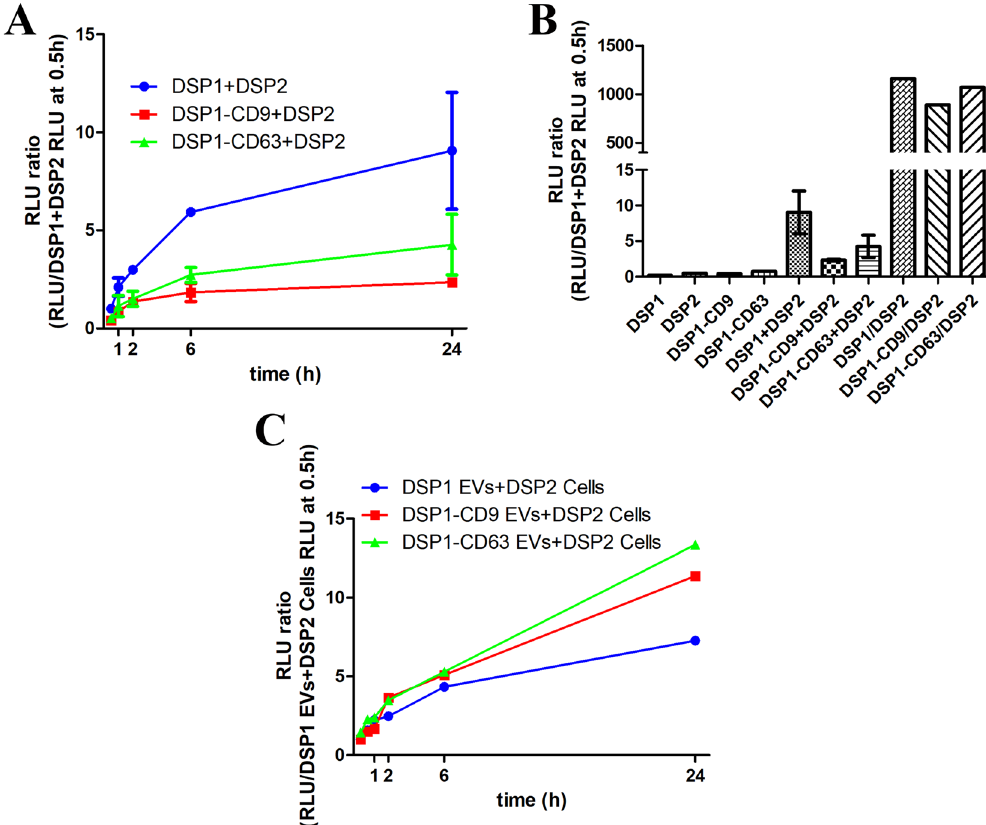
Figure 2. DSP1 and DSP2 in vitro re-association assessment. ( A) DSP1 and DSP2 reassociation kinetics in cell lysates. SUM159 stably expressing DSP1, DSP1-CD9 or DSP1-CD63 were lysed and each lysate was mixed with a cell lysate from DSP2-expressing cells. Renilla luciferase activity was measured with Stop&Glo Renilla reagent at the indicated times. n = 2. ( B ) Comparison of the signal obtained with Stop&Glo reagent at 24 h from combinations of cell lysates of cell expressing DSP1 constructs with cell lysates from cells expressing DSP2 (DSP1 + DSP2, DSP1-CD9 + DSP2 and DSP1-CD63 + DSP2) and with cell lysates from cells that co-expressed both constructs (DSP1/DSP2, DSP1-CD9/DSP2 and DSP1-CD63/DSP2). Negative controls of independent lysates from cells expressing either DSP1, DSP2, DSP1-CD9 or DSP1-CD63 are depicted. (C) Reassociation kinetics with EV lysates. EVs were isolated from conditioned media of SUM159 stably expressing DSP1, DSP1-CD9 or DSP1-CD63 by ultracentrifugation at 100000 g, lysed and each lysate was mixed with a cell lysate from DSP2-expressing cells. Renilla luciferase activity was measured with Stop&GloRenilla reagent at the indicated